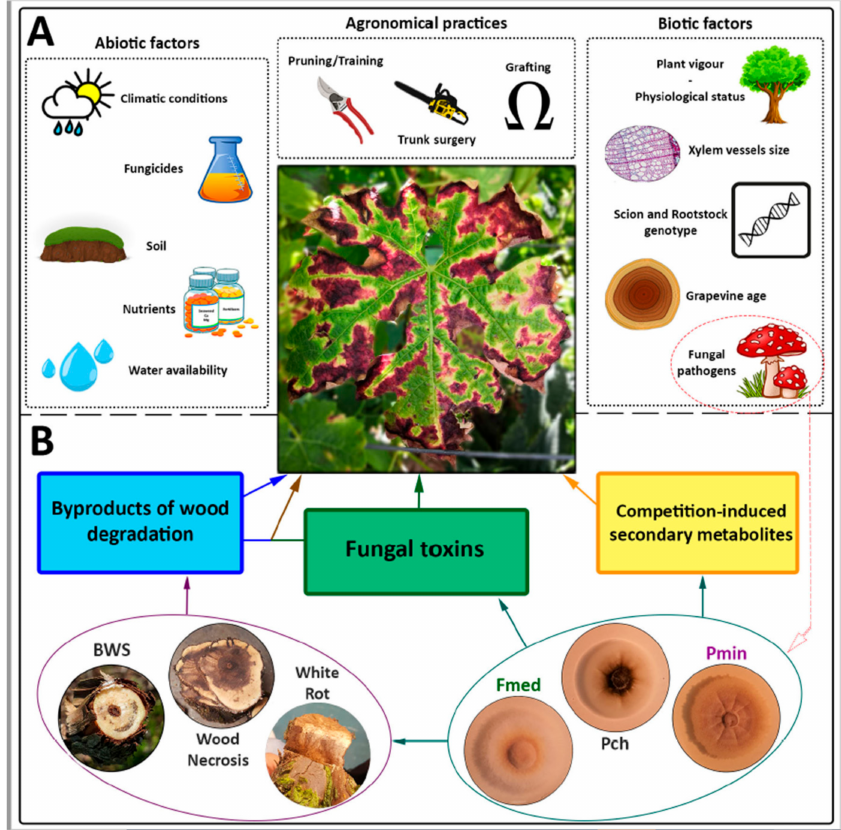
Figure 1. Agronomical practices and biotic and abiotic factors known to influence leaves’ expression of esca symptoms in leaves ( A ). Three main hypotheses for leaf symptoms triggering fungal pathogens and related symptoms in the wood ( B ). BWS: brown wood streaking, Fmed: Fomitiporia mediterranea , Pch: Phaeomoniella chlamydospora , Pmin: Phaeoacremonium minimum . References for ( A ):